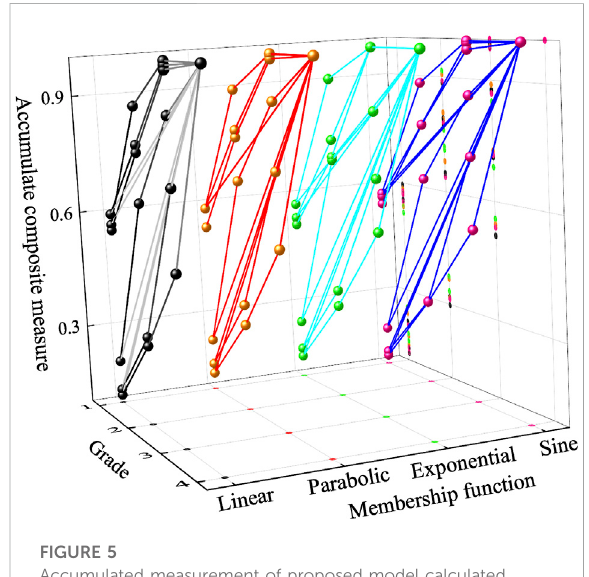
FIGURE 5 Accumulated measurement of proposed model calculated by four functions.